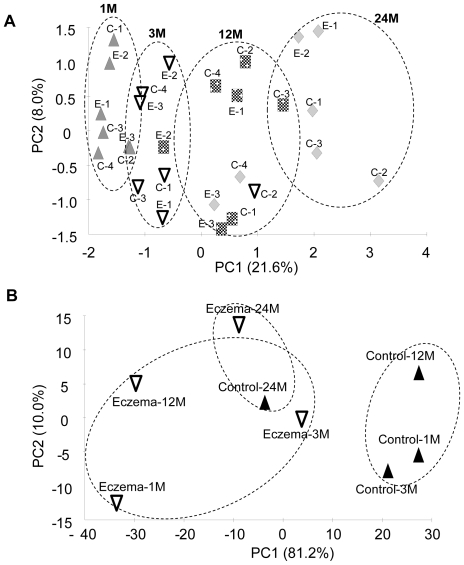
Principal component analysis (PCA).(A) PCA was performed based on the presence and absence of OTUs identified in each individual at different time-points: upward triangle represents samples at 1 month; downward triangle represents samples at 3 months; square represents samples at 12 months; kite represents samples at 24 months. PCA indicated that presence and absence of OTUs are time-mediated. (B) PCA was performed based on abundance of classified OTUs within the eczema and non-eczema control health groups at different time-points. PCA indicated that abundances of specific bacterial targets correlated to the eczema status of infants during early stages of infancy.